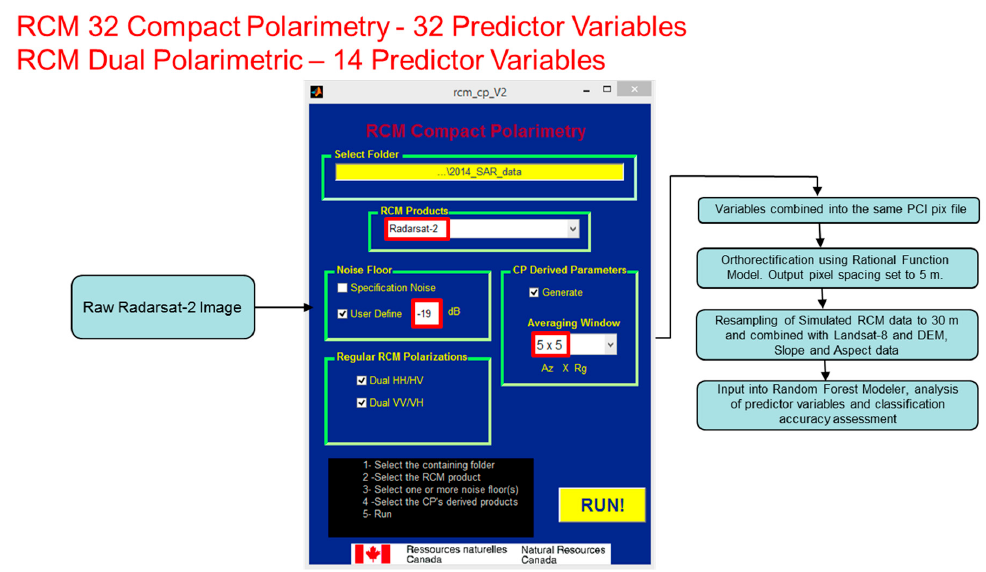
Figure 4. A sample of the processing steps used in the RCM simulator software to produce the predictor variables in the simulated RCM RF models. For the dual pol models 14 predictor variables were available, while for the compact polarimetry (CP) models 32 were available. The simulator was run once with a noise equivalent sigma zero (NESZ) of − 19 dB and a second time with an NESZ of − 25 dB.